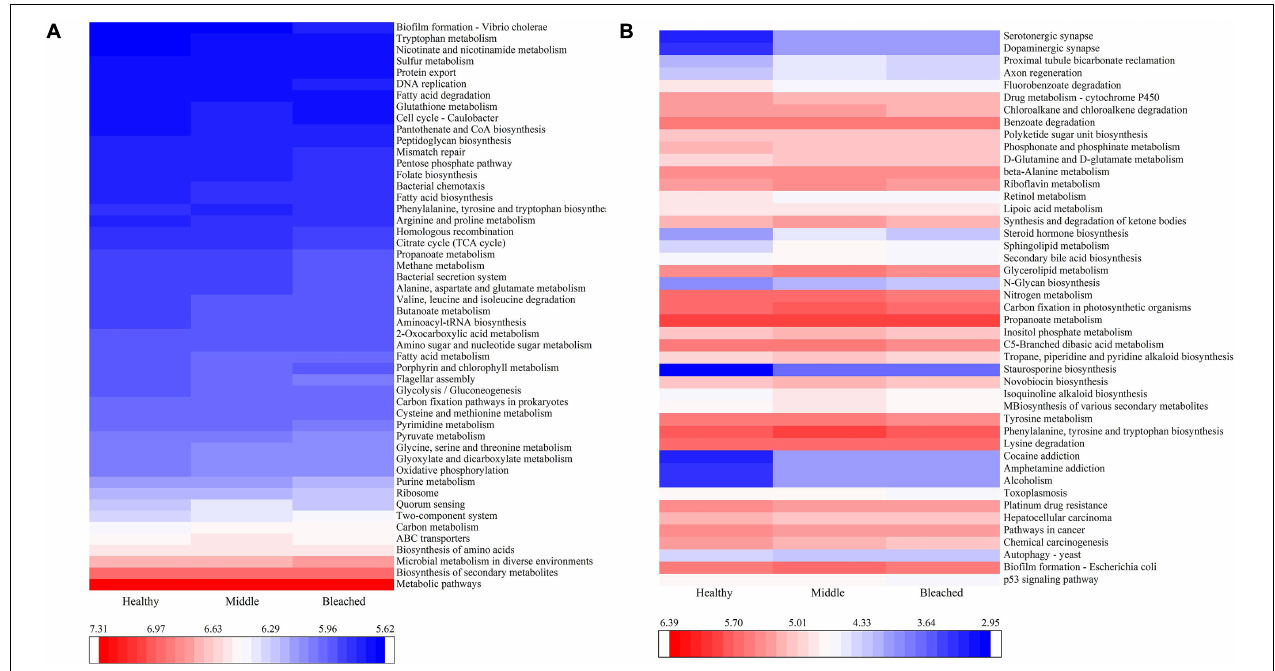
FIGURE 6 | PICRUSt2 function prediction showing (A) the abundances of the top 50 of predicted pathways and (B) the abundances of the predicted pathways involved in diseases, metabolism, cellular processes, and organismal systems with significant differences among the three P. onkodes